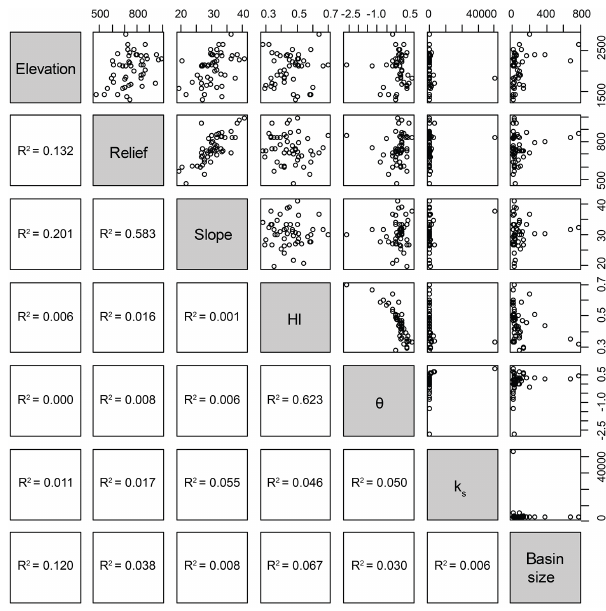
Figure 6. Correlation matrix of the topographic variables extracted from the DEM (mean elevation, relief, slope, HI, concavity, k s ) and basin size. The strength of correlation for each pair is given by the coefficient of determination, r 2